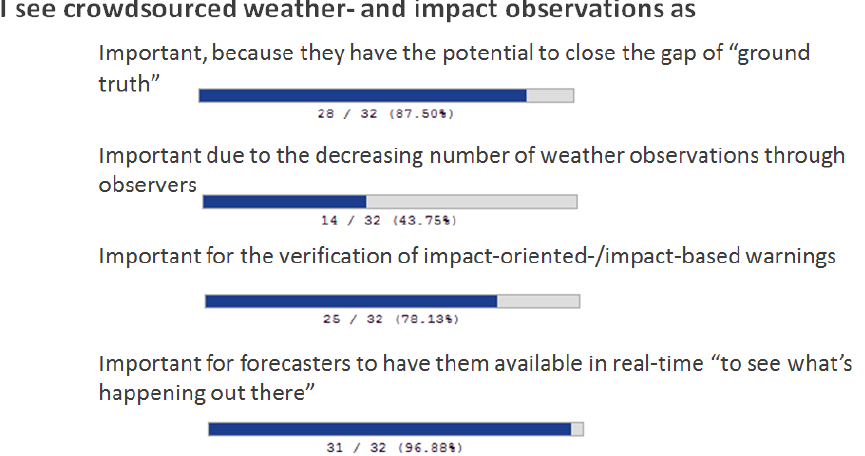
Figure 6. Opinions regarding crowdsourced weather- and impact observations of 32/37 respondents. Crowdsourcing is seen as an appropriate way to close the gap of “ground truth” and important for the verification of IoWs/IbWs. Especially the real-time availability to “see what’s happening out there” in order to adapt warnings in terms of a feedback loop is considered to be important for operational meteorologists.